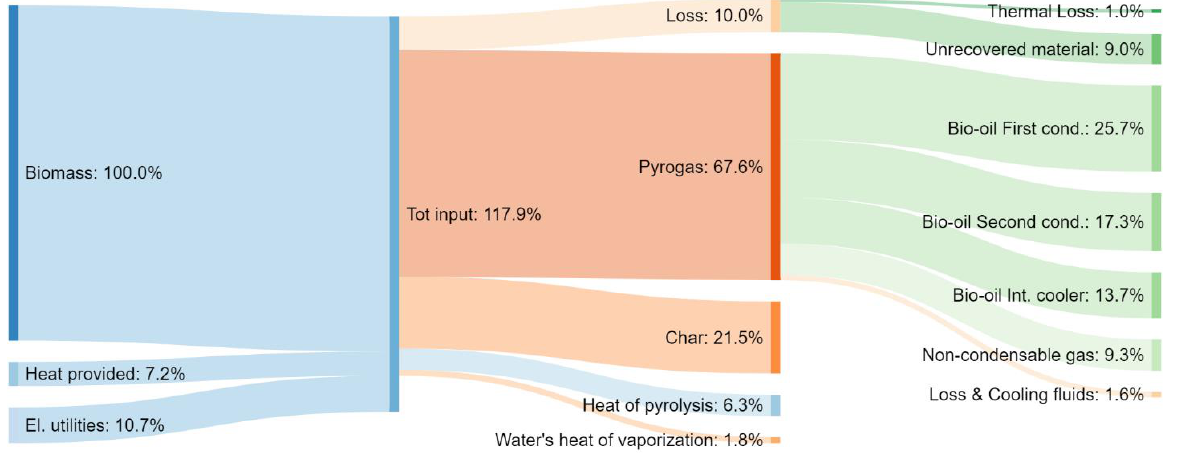
Figure 9. Energy balances (percentages expressed as a fraction of the chemical energy of the wet biomass at the inlet).